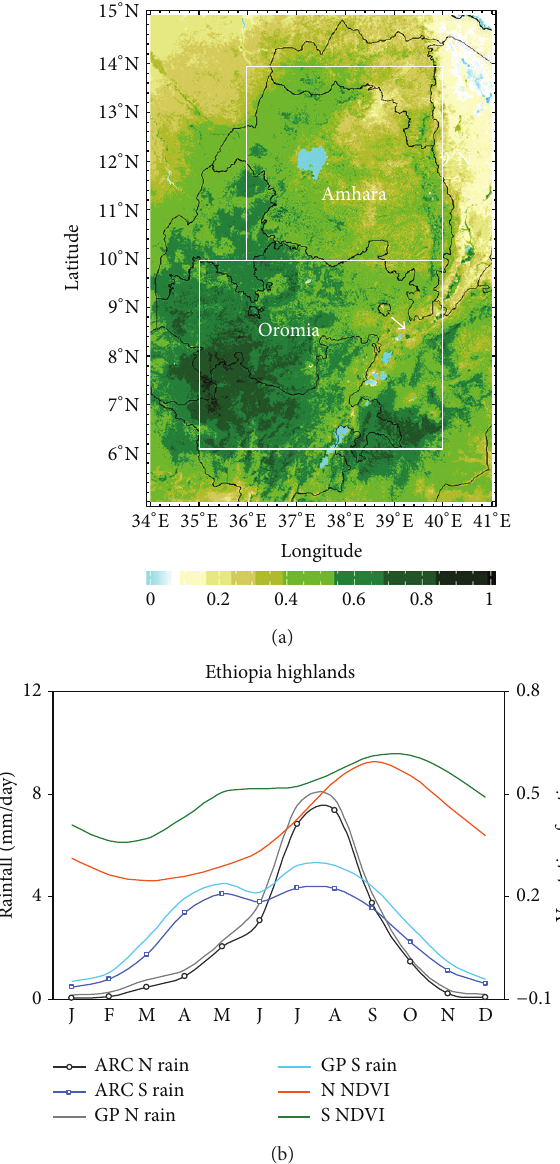
Figure 1: (a) Vegetation fraction averaged 2000–2012 from MODIS, with state boundaries, target boxes and the national experimental farm (arrow). (b) Mean annual cycle of ARC2/GPCC6 rainfall and vegetation NDVI 1981–2006.